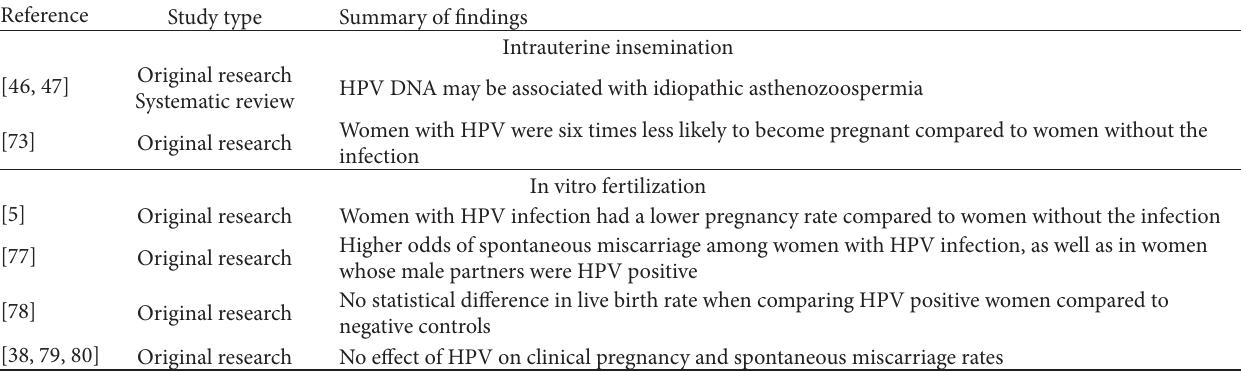
Table 2: Summary of literature regarding the effect of HPV on assisted reproductive